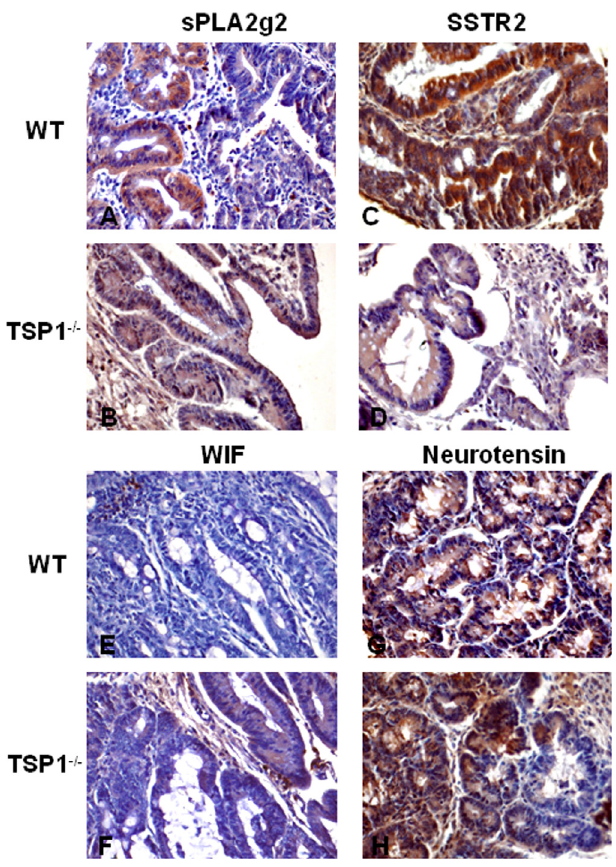
Fig 4. Validation of transcripts involved in inflammation and cancer by IHC. The expression of some transcripts involved in epithelial proliferation and the immune response was examined by IHC. PLA2g2 immunostaining of these tumors showed a focal localization in glands of WT tumors (A). This same protein was diffusely expressed in the glands and stroma of TSP-1 -/- tumors (B). SSTR2 was intensely expressed in WT tumors (C) while the staining in TSP-1 -/- lesions was rather light or even negative (D). WIF1 was focally located in the lamina propria of WT cancers (E). Cytoplasmic staining was detected in isolated foci of cells in malignant glands in TSP-1 -/- tumors (F). Neurotensin (NTS) was predominantly localized in the malignant epithelial cells. While WT tumors showed intense and diffuse staining (G), some of the tumors developed in TSP-1 -/- showed focal areas lacking NTS staining